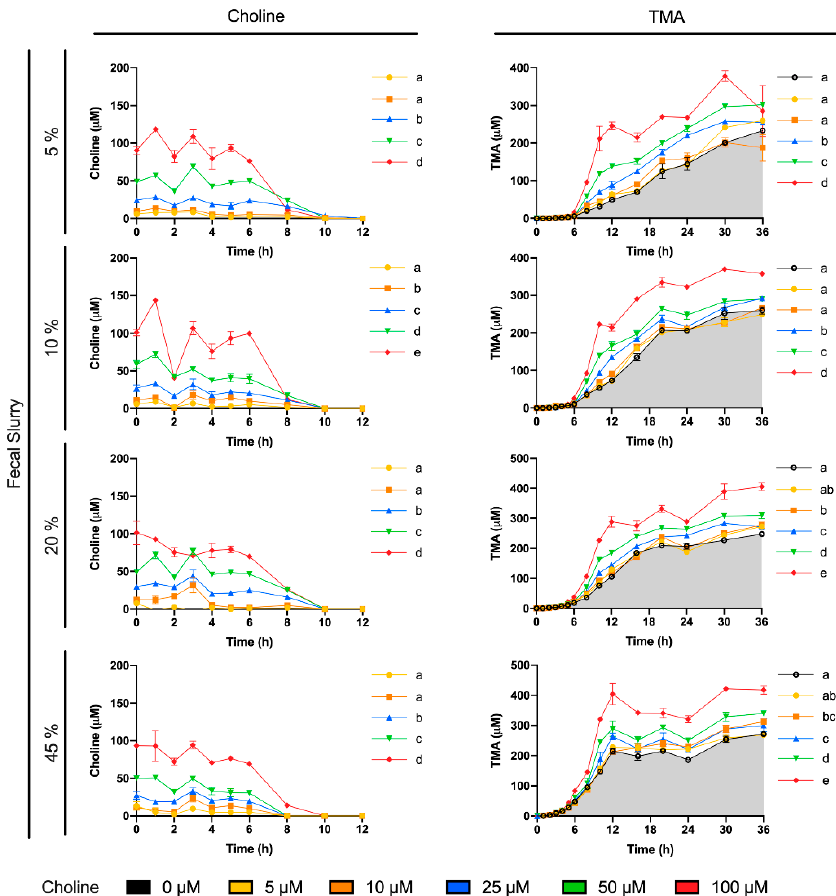
Figure 1. Choline ( left ) and TMA ( right ) kinetic curves obtained by fermenting exogenous choline (0–100 µM) with different percentages of fecal slurry (5–45% v / v ). For choline curves, data beyond 12 h are not shown for clarity (concentrations were all in the non-detected or non-quantified range), and time-matched choline concentrations in the background (from the mean detected choline levels in the 0 µM choline treatment) are subtracted from choline-supplemented conditions in order to reflect only exogenous choline levels. Results are expressed as mean (µM choline or TMA) ± SEM ( n = 3). Different letters indicate statistical differences ( p < 0.05) in main effect of choline dose or fecal slurry percentage by two-way ANOVA (Tukey’s post hoc test). Factors for two-way ANOVA were choline concentration or fecal slurry proportion and time. Grey shading indicates background TMA production.